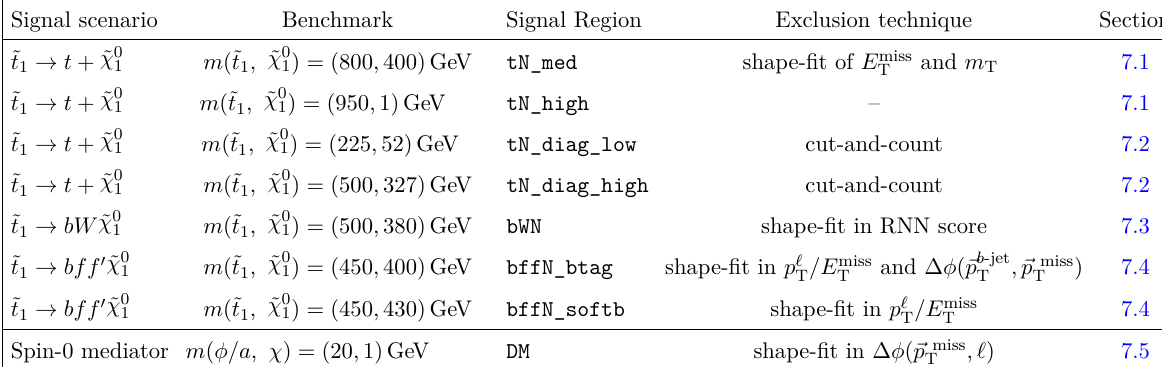
Table 1. Signal scenarios, benchmark models and signal regions. For each SR, the table lists the analysis technique used for exclusion limits. The last column points to the section where the signal region is defined. For tN_high no exclusion technique is defined. The tN_med shape-fit also covers the tN_high -like phase